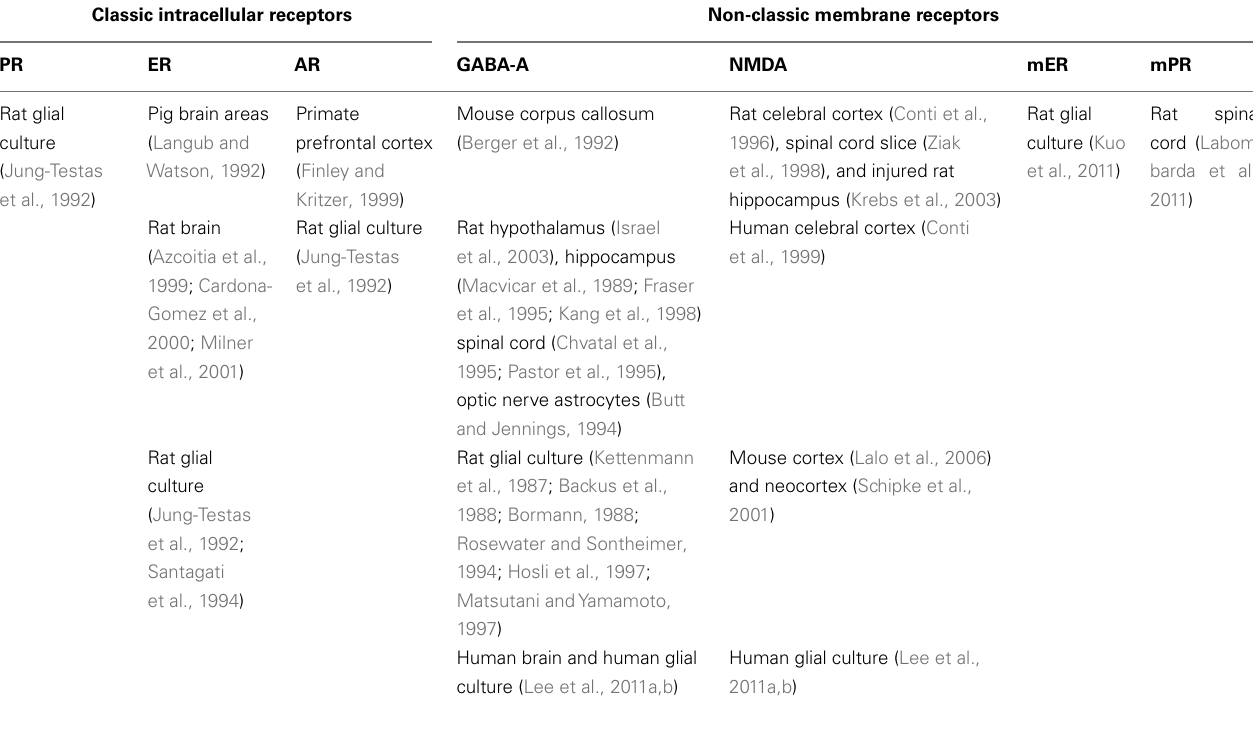
Table 1 | Distribution of major classic and non-classic receptors for neurosteroids in astrocytes. Classic intracellular